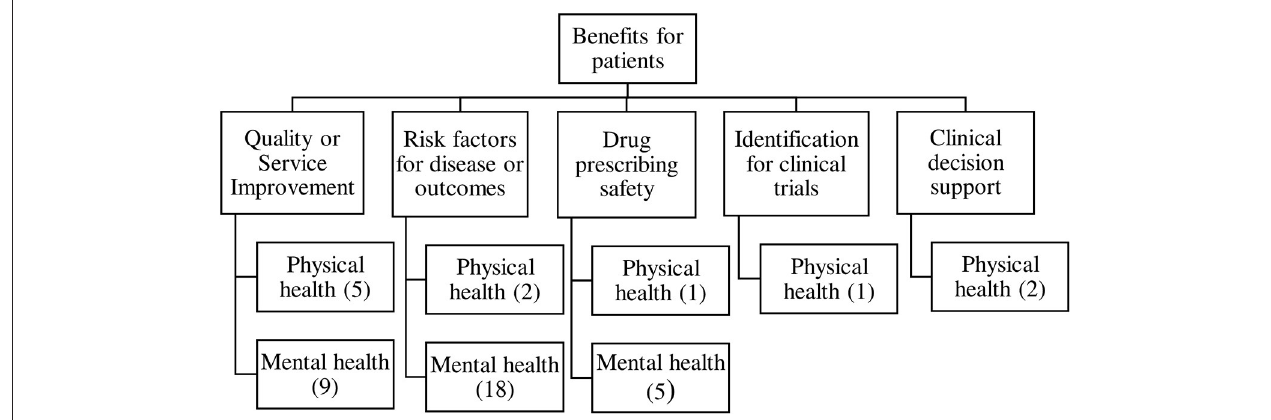
FIGURE 2 | Taxonomy of clinical benefits from analysis of clinical free text